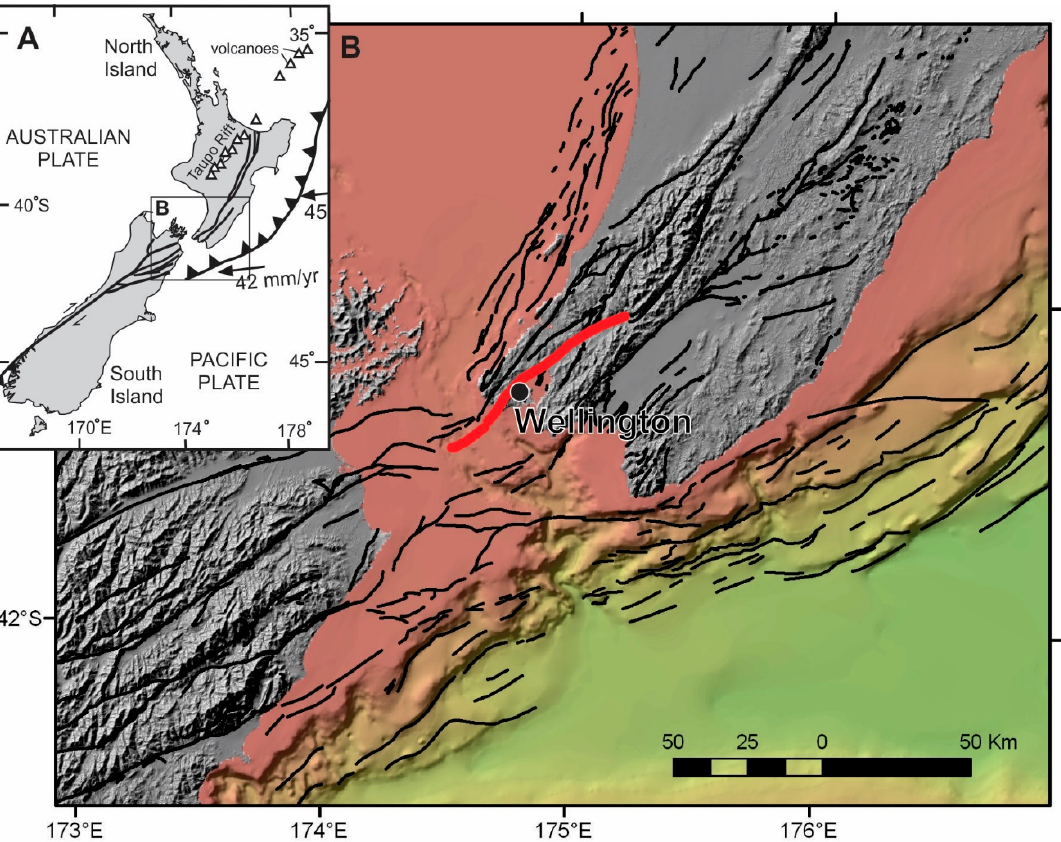
Figure 1. ( A ) Tectonic setting of New Zealand; ( B ) Known active faults of central New Zealand, with the Wellington Fault shown in red.